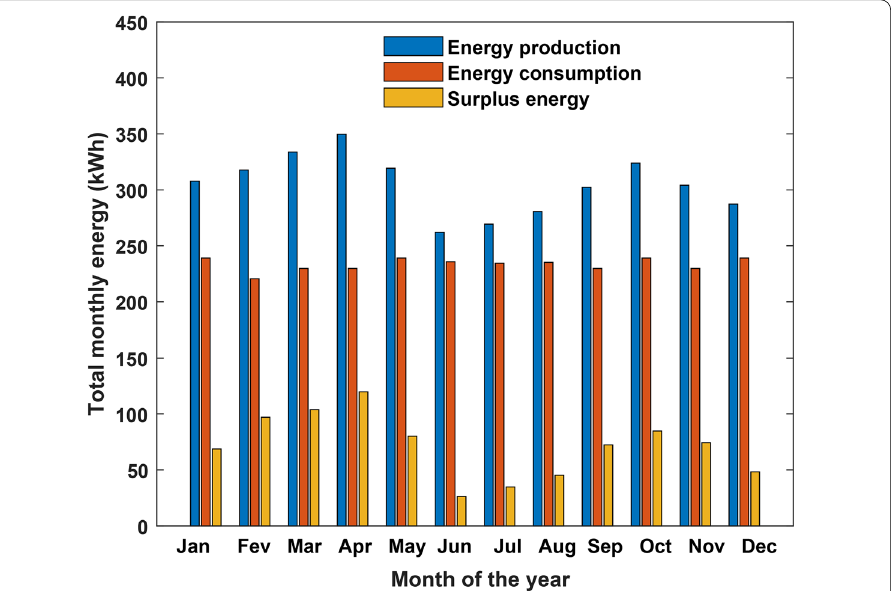
Fig. 13 Graphical representation of the total monthly energy generation, energy consumption and surplus of energy for the optimal configuration corresponding to LWSP of